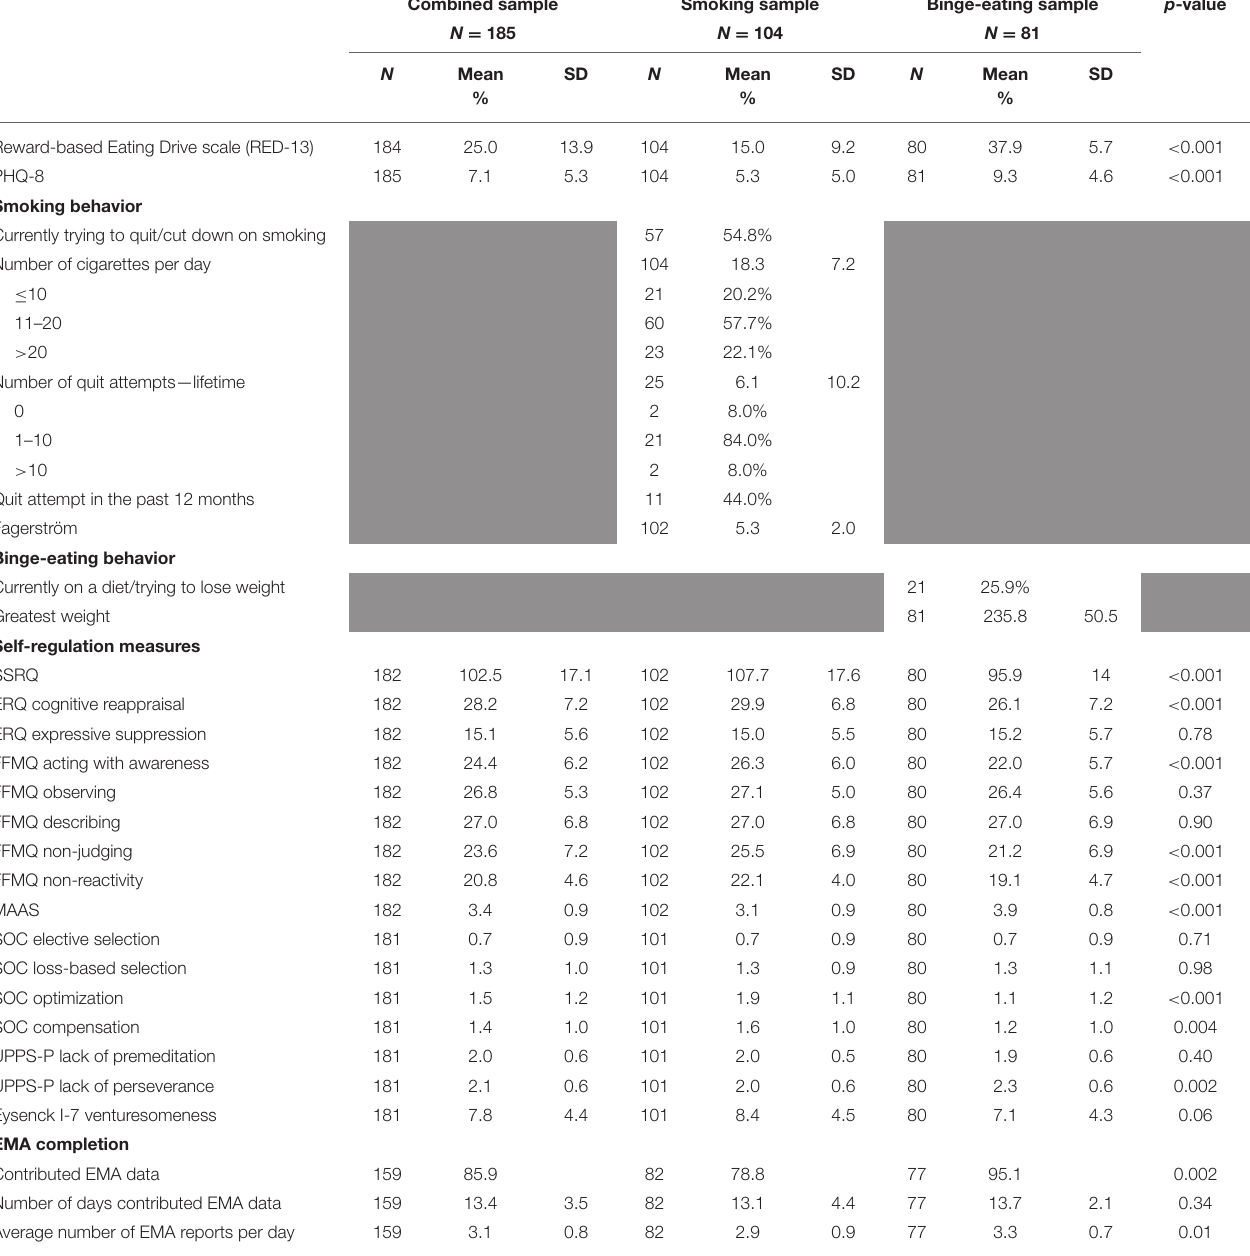
TABLE 2 | Baseline, study-specific measures in the combined, smoking, and binge-eating samples. Combined sample Smoking sample Binge-eating sample p